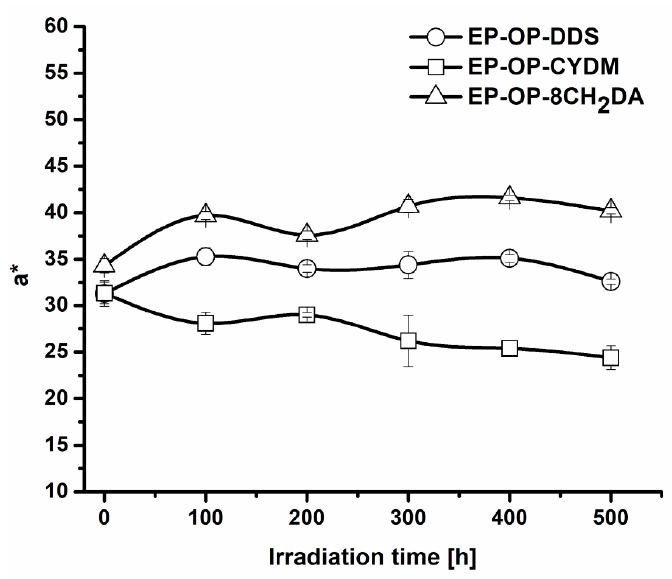
Figure 2. Variation of the a * parameter with irradiation time.